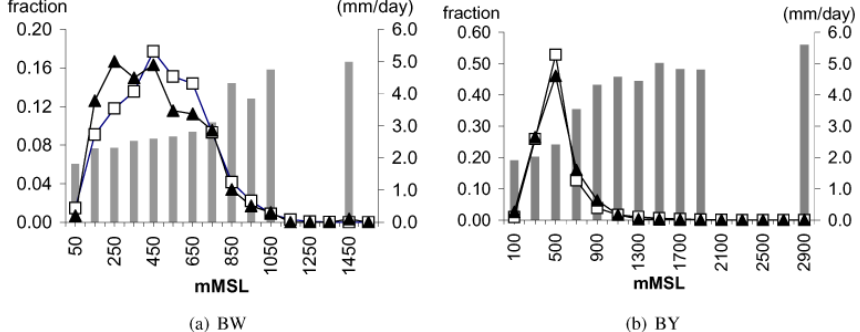
Fig. 2. Hypsometric distribution (dark triangle, left ordinate), altitudinal distribution of rain gauges (light square, left ordinate) and mean pre- cipitation (gray bars, right ordinate) for each elevation band in BW and BY. The hypsometric distribution was determined from a topographic data set with a resolution of 100m.